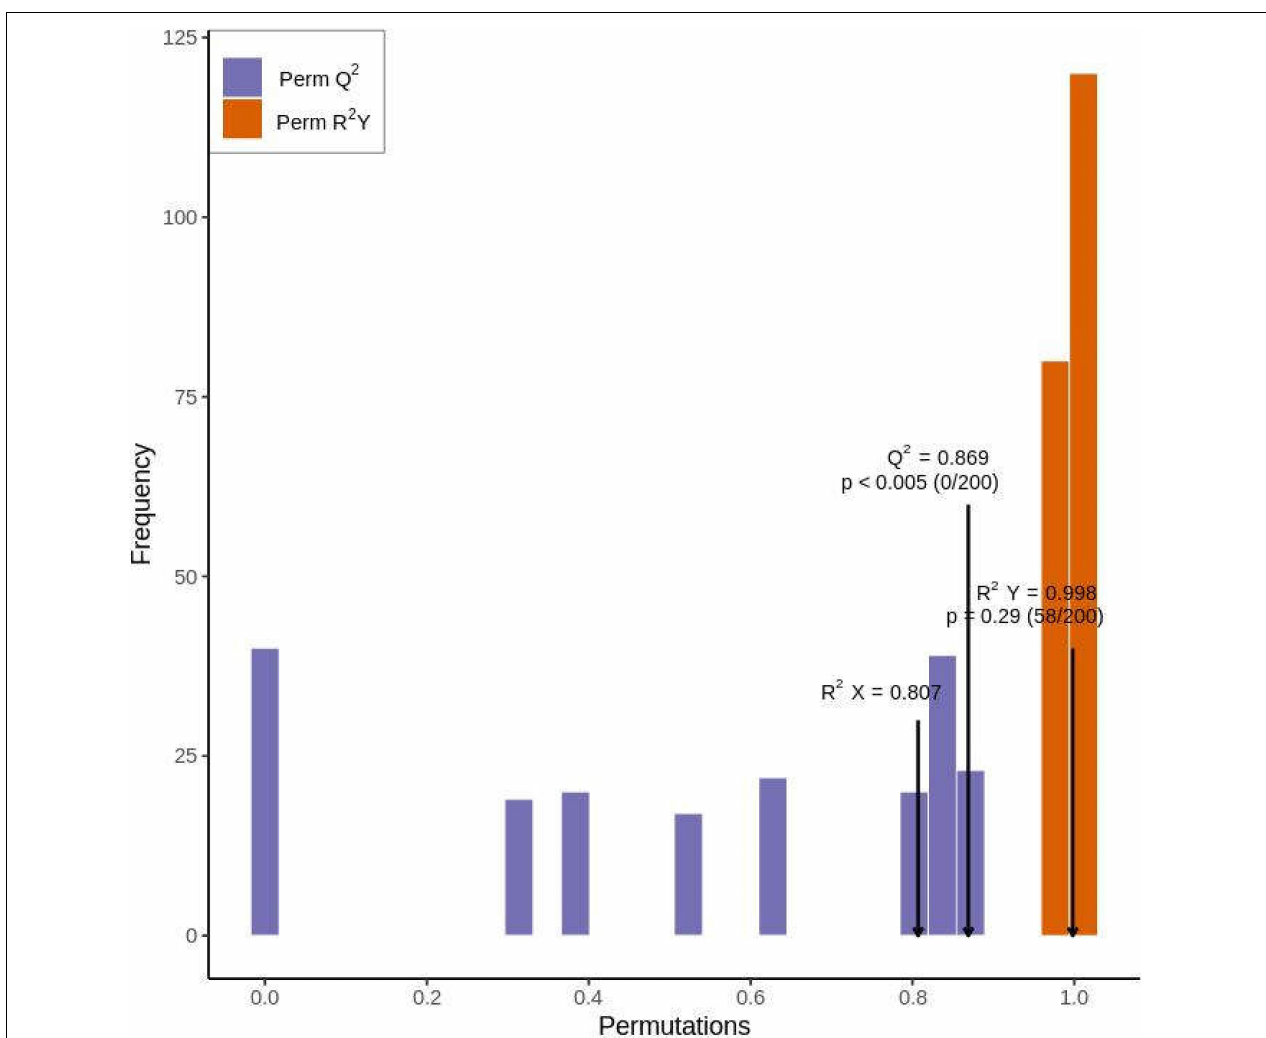
FIGURE 5 | Orthogonal partial least squares discriminant analysis model validation diagram of metabolites in Qssg and Lc fruits ( p < 0.005; n = 200, that is, 200 alignment experiments were carried